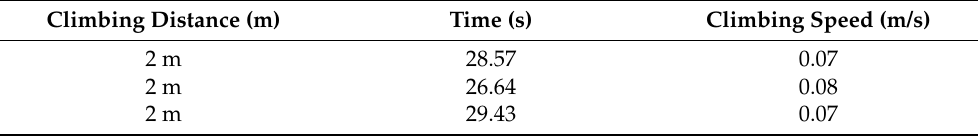
Table 5. Test of climbing speed.